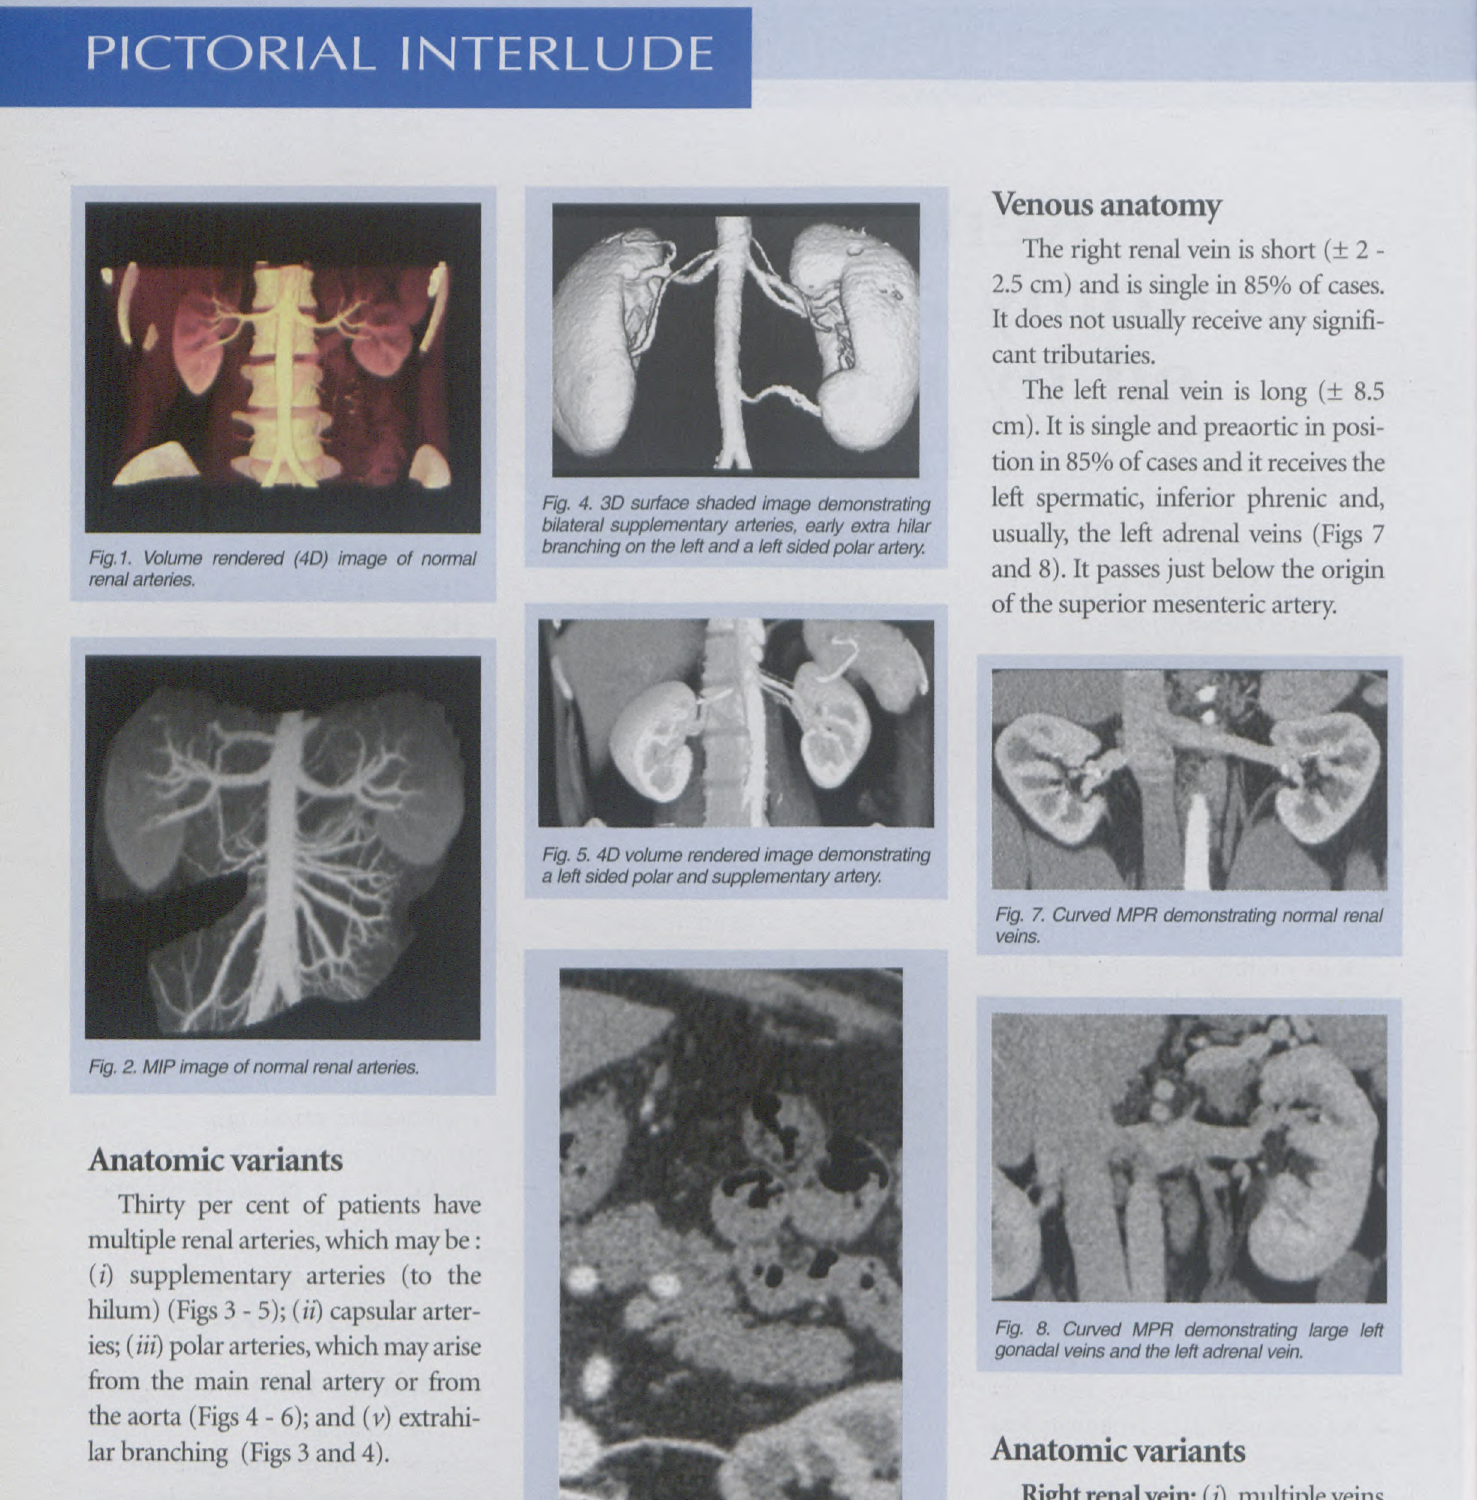
Fig. 8. Curved MPR demonstrating large left gonadal veins and the left adrenal